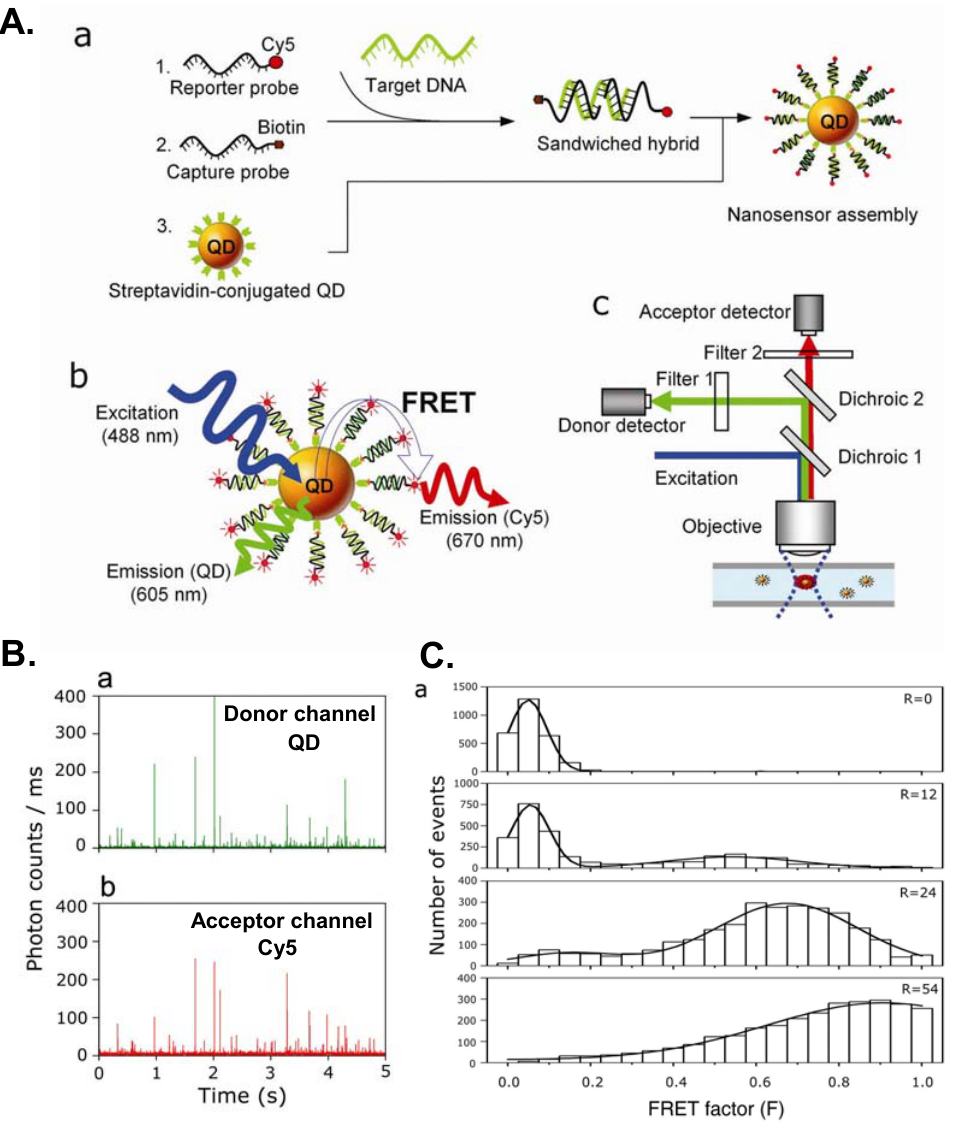
Figure 7. Single QD-Based DNA Nanosensor . A. Schematic of single-QD-based DNA nanosensors. a-Conceptual scheme showing the formation of a nanosensor assembly in the presence of targets. b- and a QD donor in a nanosensor